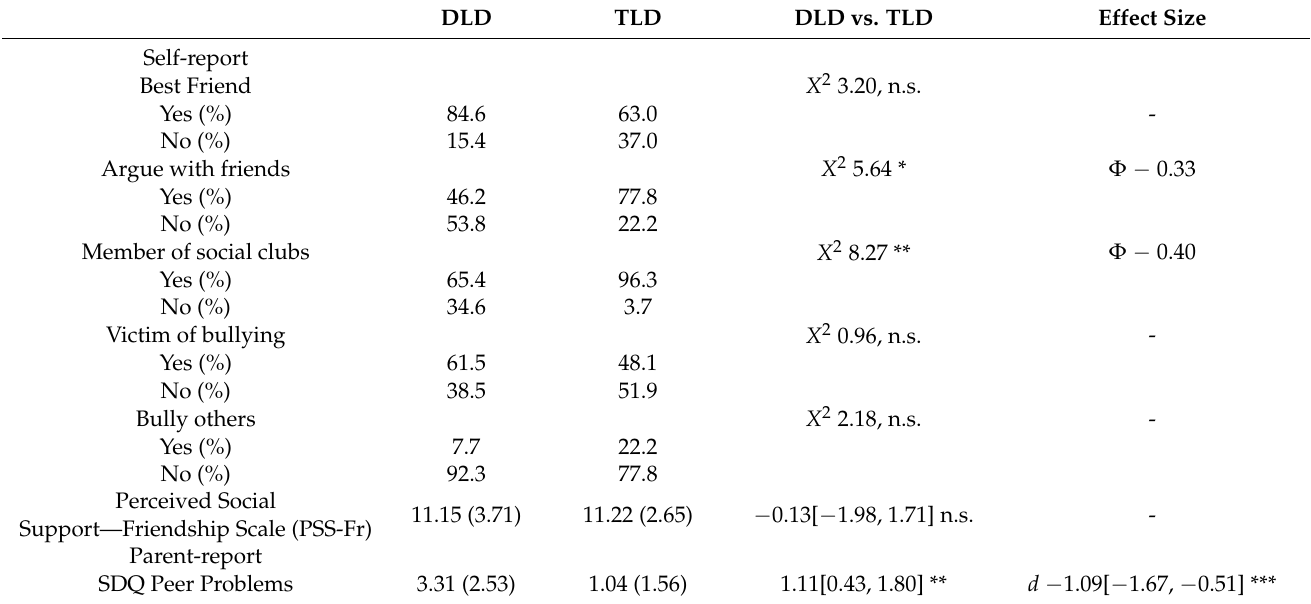
Table 3. Mean (and standard deviation) ratings of social functioning outcomes from self-report and parent-report. DLD TLD DLD vs. TLD Effect Size